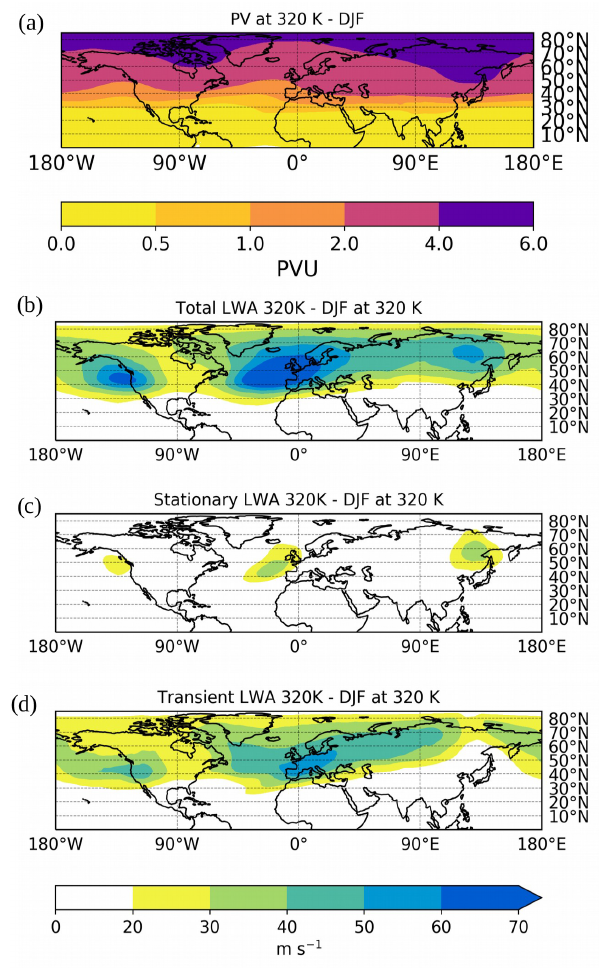
Figure 1. Panel (a) shows time mean Ertel PV for DJF on the 320K isentropic surface (in potential vorticity units (PVU), 1PVU ≡ 10 − 6 kgKm 2 s − 1 ); panel (b) shows total (i.e. stationary and tran- sient) LWA (colour, units ms − 1 ) on the 320K isentrope for DJF. Panel (c) is the same as (b) but for stationary LWA. Panel (d) is the same as (b) but for transient